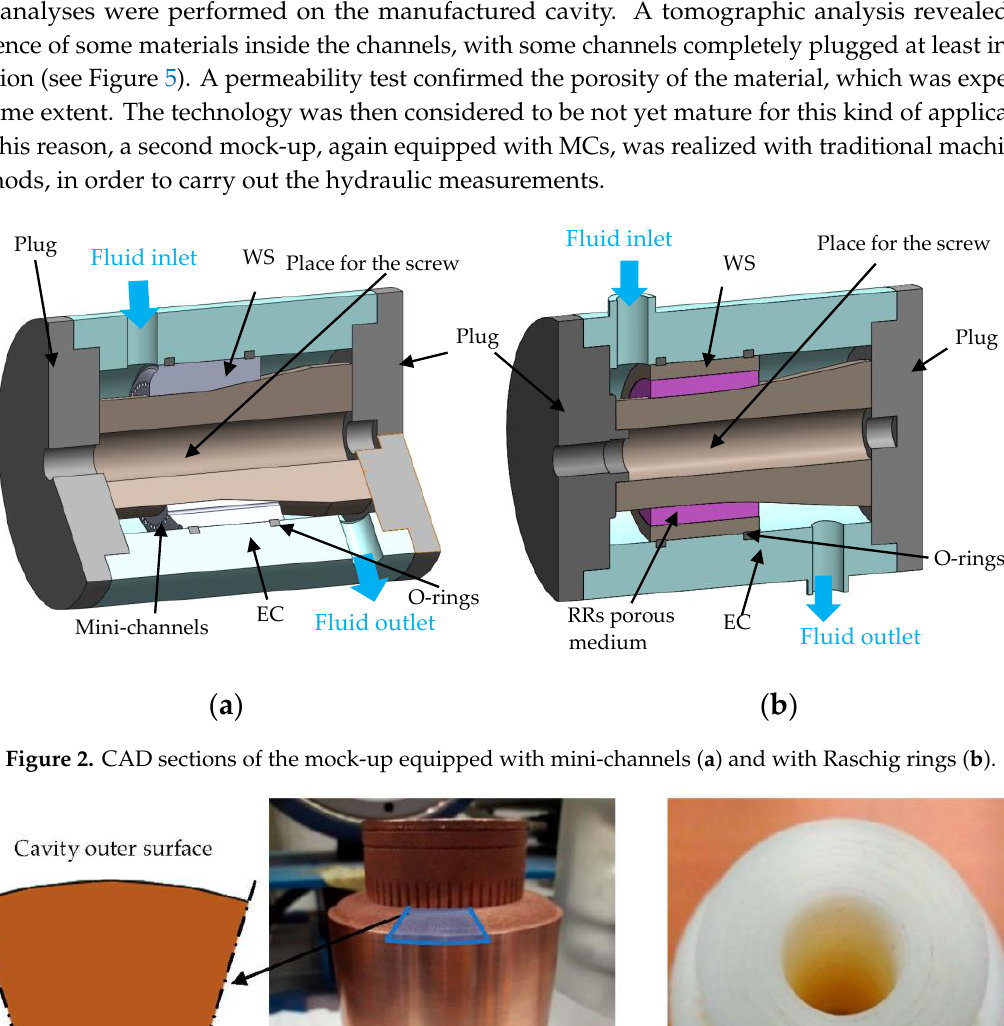
Figure 3. Cavity mock-ups equipped with mini-channel (MC): ( a ) copper cavity with a zoomed-in view showing the mini-channel cross section; ( b ) nylon cavity.